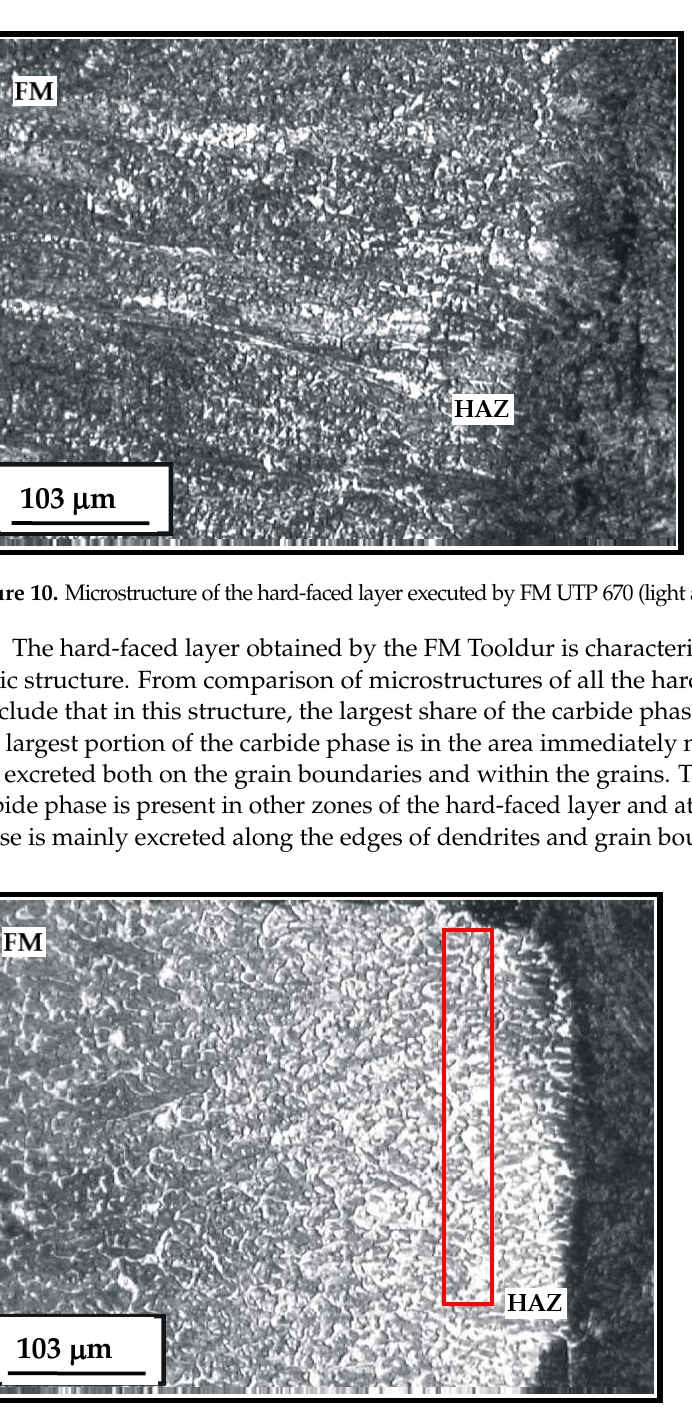
Figure 9. Elongated dendritic structure of the hard-faced layer executed by the GTAW welding pro- cedure and filler metal DUR 600-IG.